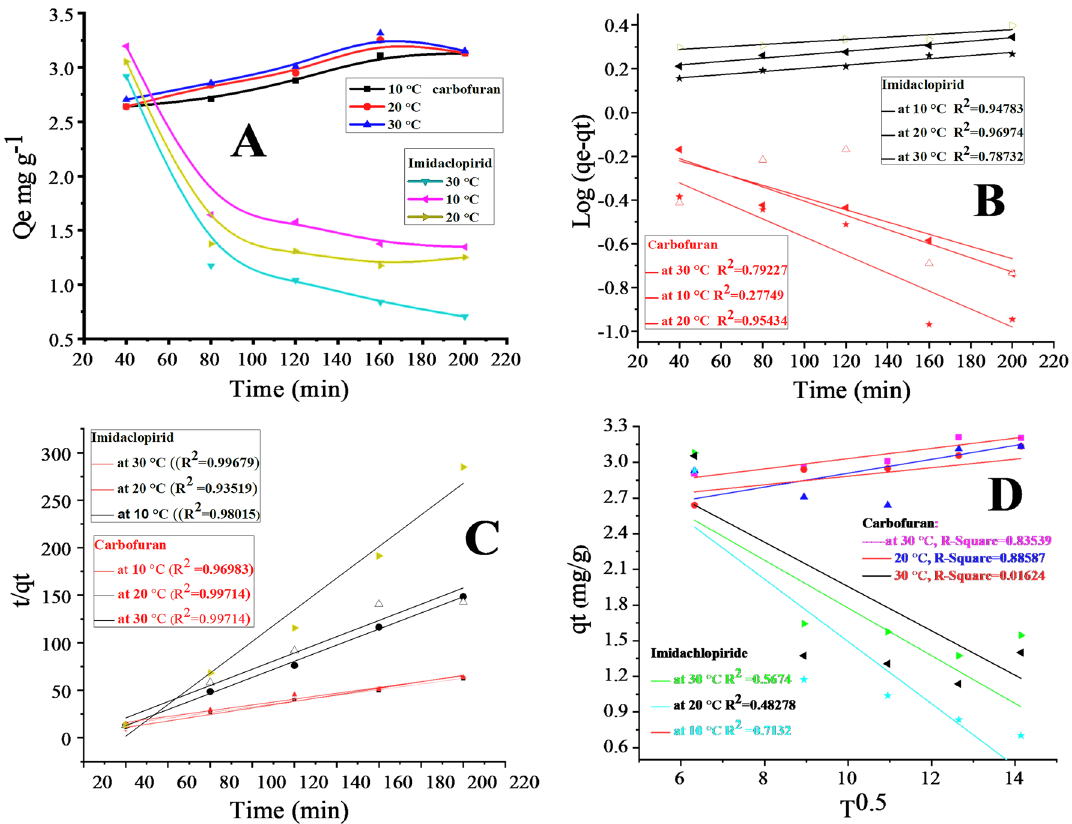
Figure 9. General adsorption kinetic model: ( A ), Carbofuran; at 10 ℃ ( ■ ), 20 ℃ ( ● ), and 30 ℃ ( ▲ ); imidacloprid; 10 ℃ (◀), 20 ℃ (▶) and 30 ℃ ( ▼ ). Pseudo first order kinetic model: ( B ), imidacloprid; at 10 ℃ ( ☓ ), 20 ℃ (◀) and 30 ℃ ( ★ ), carbofuran; at 10 ℃ (∆), 20 ℃ (◀) and 30 ℃ ( ★ ), Pseudo second order kinetic model: ( C ), imidacloprid; at 10 ℃ ( △ ), 20 ℃ ( ▲ ) and 30 ℃ ( ● ), carbofuran; at 10 ℃ ( ☓ ), 20 ℃ ( ▲ ) and 30 ℃ ( × ) intra particle diffusion model: (D), carbofuran; at 10 ℃ ( ■ ), 20 ℃ ( ▲ ) and 30 ℃ ( ● ) imidacloprid; at 10 ℃ ( × ), 20 ℃ ( ▲ ) and d 30 ℃ ( ▲ ) during the adsorption on the